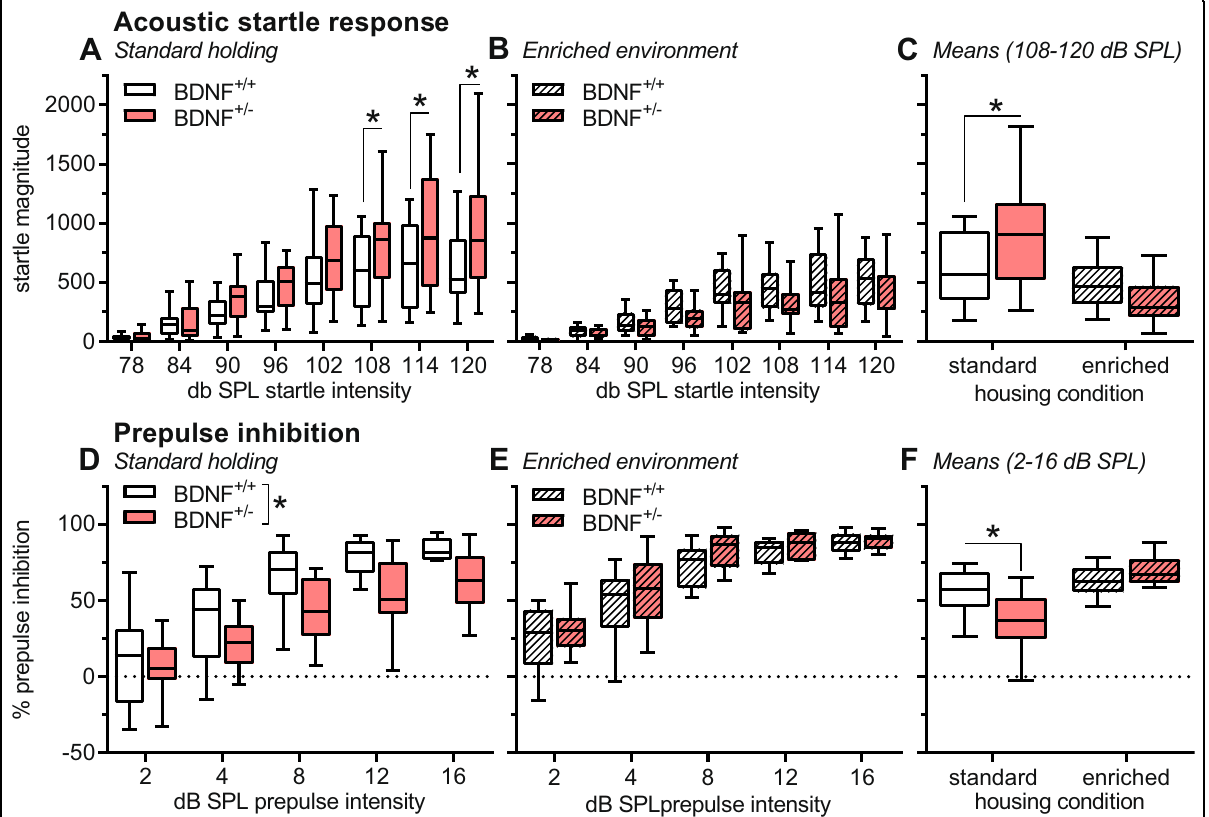
Fig. 3 EE rescued increased startle reactivity and PPI de fi cits in BDNF + / − mice. A , B Startle magnitudes using different startle stimulus intensities and ( C ) mean startle magnitudes (only startle stimuli with 108-, 114-, and 120-dB SPL). (A) Startle reactivity to high startle stimulus intensities was increased in BDNF + / − mice after standard housing. B After enriched environment, startle magnitudes were not affected by genotype demonstrating ( C ) that enriched environment rescues the increased startle reactivity in BDNF + / − mice. (D – E) Percent PPI (mean + SEM) using different prepulse intensities and ( F ) overall mean PPI. D PPI was reduced in BDNF + / − mice after standard housing. E After enriched environment, PPI was not affected by genotype showing ( F ) that enriched environment rescued the PPI de fi cit in BDNF + / − mice. Group sizes: standard housing: 14 BDNF + / + mice, 18 BDNF + / − mice; enriched environment: 14 BDNF + / + mice, 11 BDNF + / − mice. * P < 0.05, main effects in ANOVA ( D ) or post hoc comparisons as indicated ( A , C , F